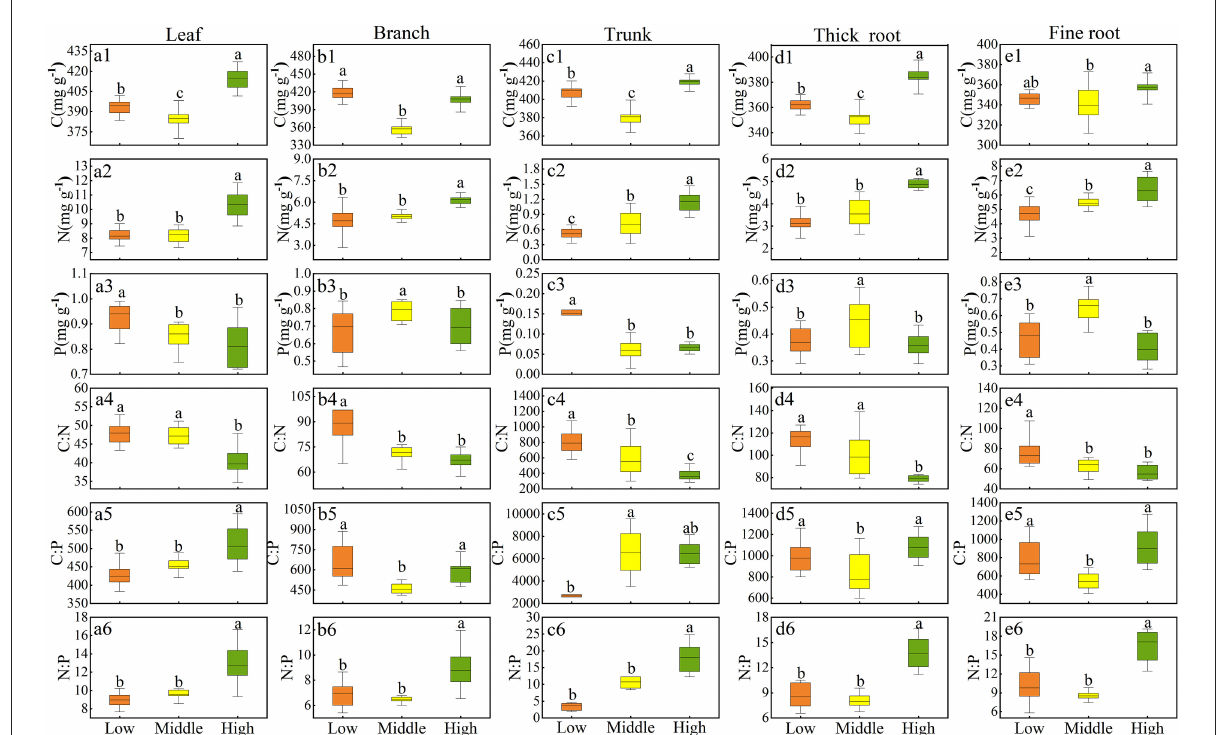
FIGURE3 Range for the stoichiometry of Qinghai spruce across three elevation levels (low, middle, and high). Box plots show the 10–90th percentiles with median lines; different letters indicate significant differences among elevation levels at P < 0.05 (Tukey’s test). C (a1–e1) , N (a2–e2) , P (a3–e3)